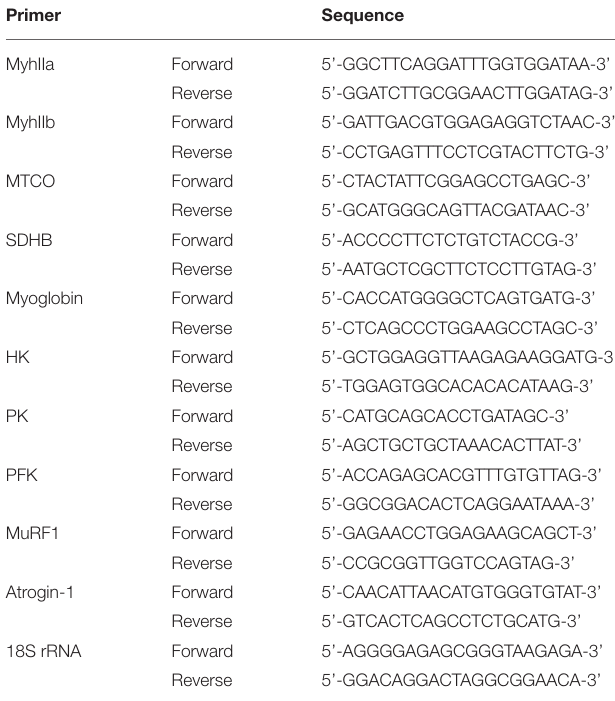
TABLE 1 | The primers used in this